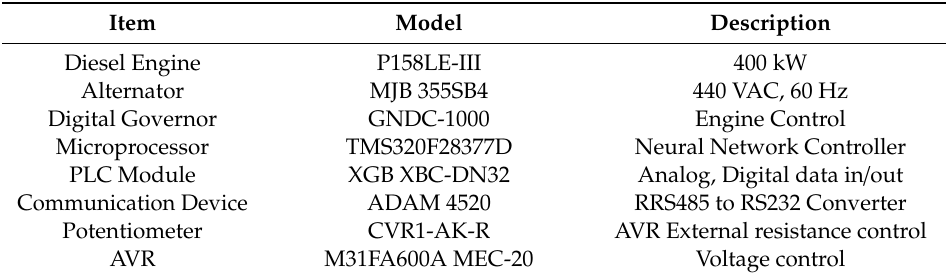
Table 2 lists the system components for the experiment and their corresponding roles. Table 2. Components of the experimental apparatus and their